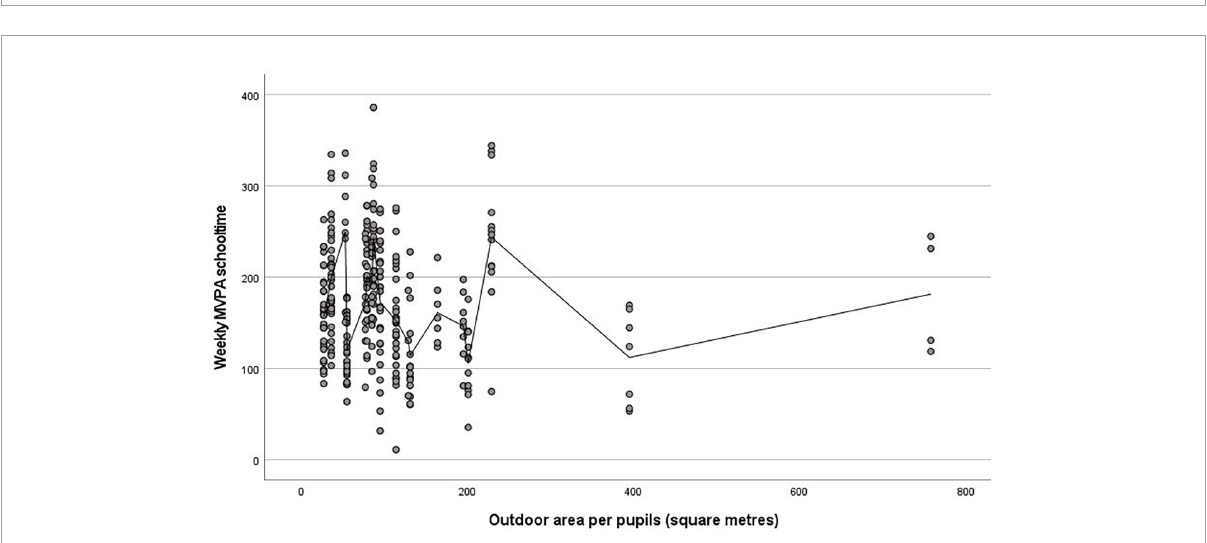
FIGURE2 Scatter diagram showing the schools’ outdoor area per pupil (in square meters) along the X -axis and the pupils’ weekly MVPA during schooltime (in minutes) along the Y -axis ( p ≤